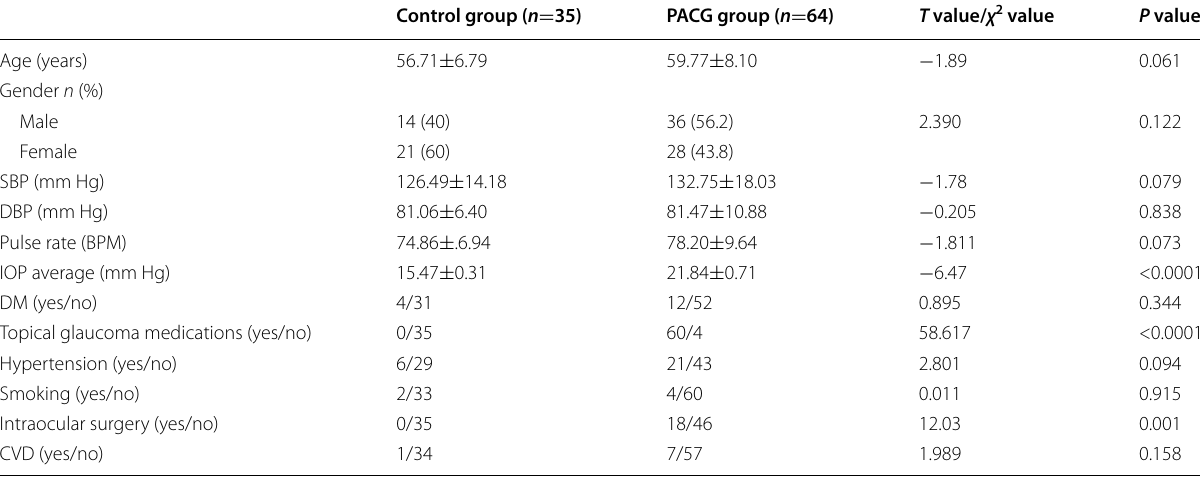
Data are expressed as mean SE for quantitative variables and frequencies (percentages) for categorical variables ± The mean difference is significant at p <0.05